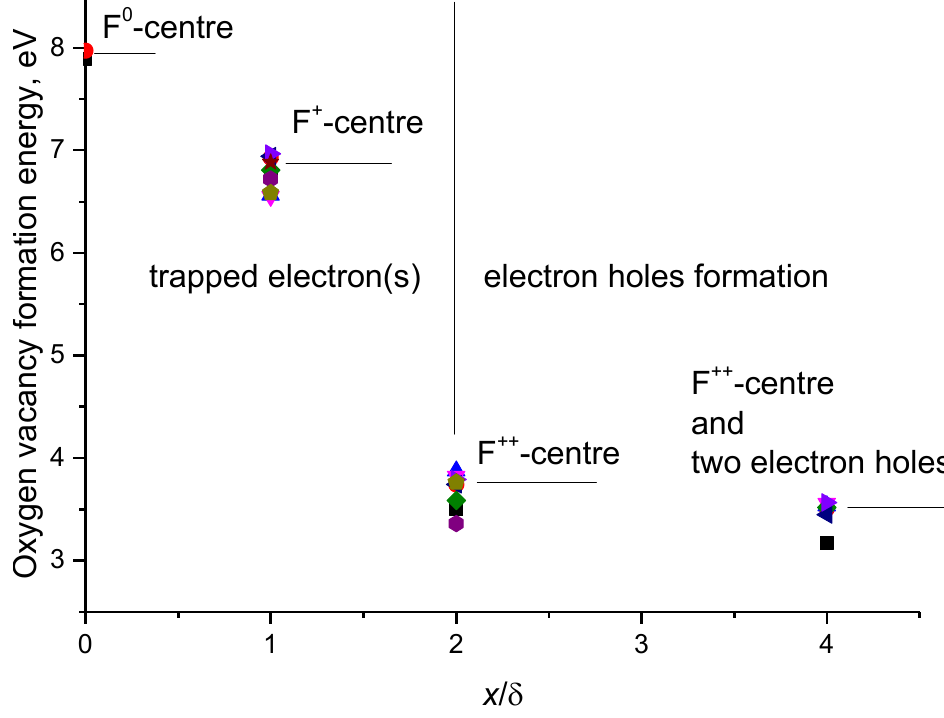
Figure 2. Two regimes of oxygen vacancy formation in La 1- x Sr x ScO 3- δ (data from Table 5). Data points of different colours denote different spatial distribution (Tables A5–A9) of Sr cations and •• as listed in Table 5.